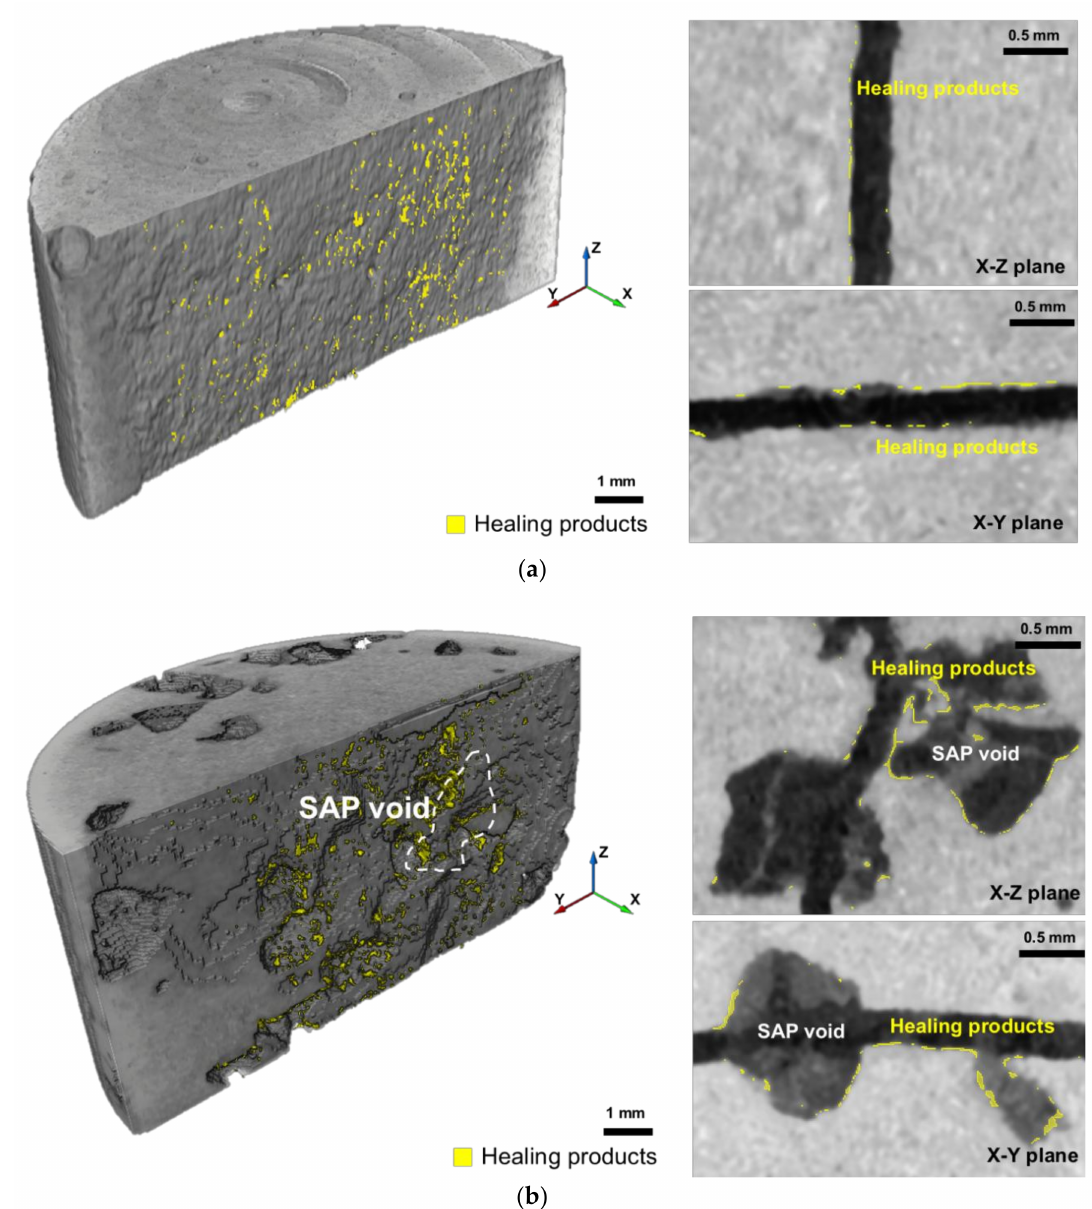
Figure 12. Three-dimensional images of healing products in the ( a ) reference specimen (REF) and ( b ) S-0.5 specimens after eight cycles, and cross-sectional images of the crack and SAP voids in X–Z and X–Y